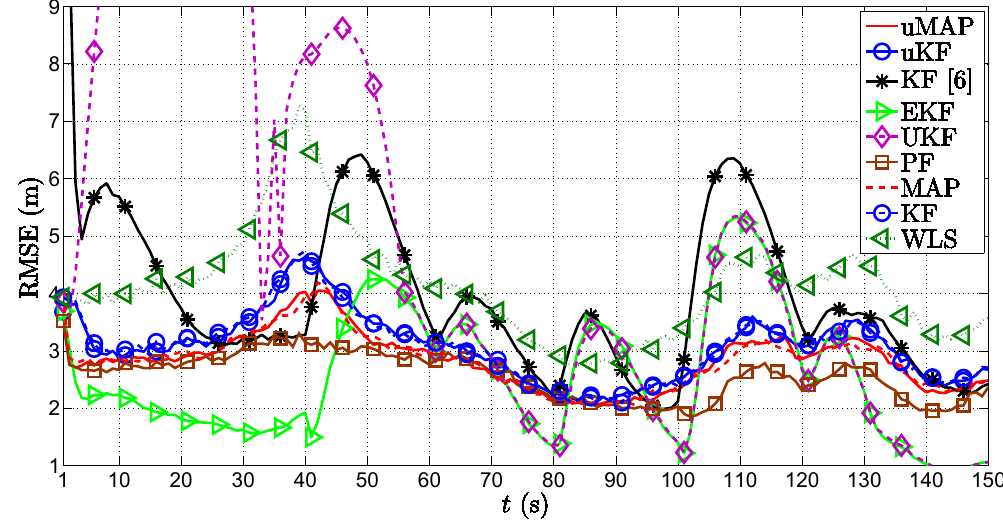
Figure 4. RMSE (m) versus t (s) comparison in the first scenario, when N = 3, (cid:107) v a (cid:107) = 0